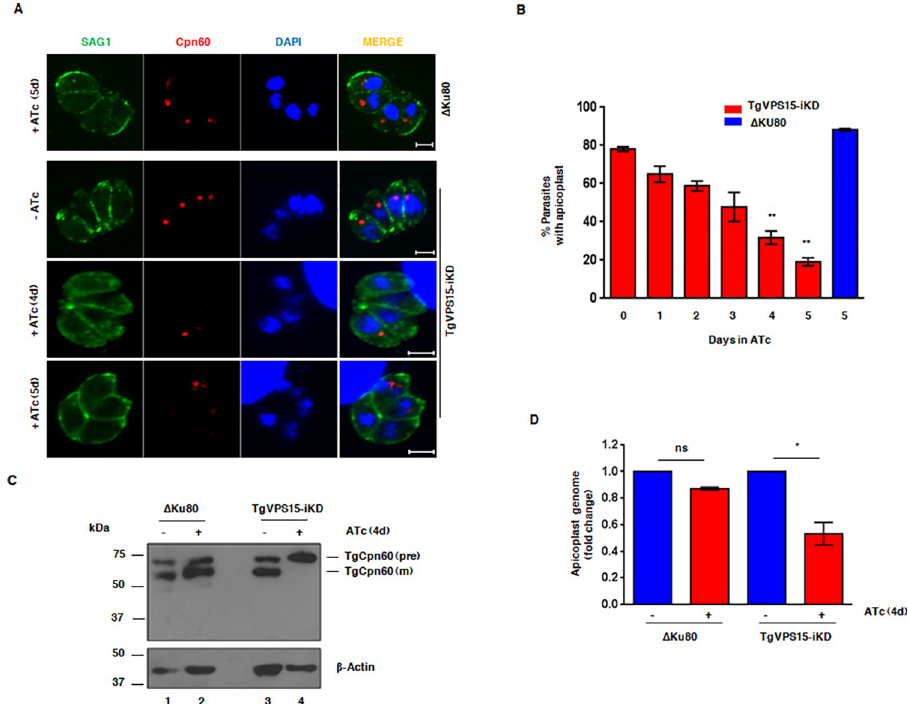
Fig 3. TgVPS15 regulates apicoplast biogenesis. A. IFA was performed on Δ Ku80 or TgVPS15-iKD parasites treated with ATc for 1-5d to detect apicoplast using an antibody against Cpn60 and the pellicle was stained using anti-SAG1. ATc treatment of TgVPS15-iKD parasites resulted in a loss of apicoplast. Representative images shown here are for experiments done after 4 and 5 days of ATc treatment. B. TgVPS15-iKD (red) or Δ Ku80 (blue) parasites were treated with ATc for indicated duration as described in panel A and IFA was performed using anti-Cpn60 antibody. % parasites with an apicoplast were counted (Mean ± SE, n = 3, �� P < 0.01, ANOVA). C. Δ Ku80 or TgVPS15-iKD parasites were treated with ATc for 96h or 4d. Western blotting was performed on parasite lysates using anti-Cpn60 antibody. Both mature (m) and precursor (pre) Cpn60 was detected in all cases except in ATc-treated TgVPS15-iKD parasites, which exhibited mainly the precursor Cpn60 form. D. Quantitative PCR was performed using total DNA from Δ Ku80 or TgVPS15-iKD parasites treated with ATc for 96h or 4d and primers specific to nuclear and apicoplast coded genes. Fold change upon ATc treatment in genomic equivalents for apicoplast, which was normalized with respect to the nuclear genome, is provided (Mean ± SE, n = 3, � P < 0.05,